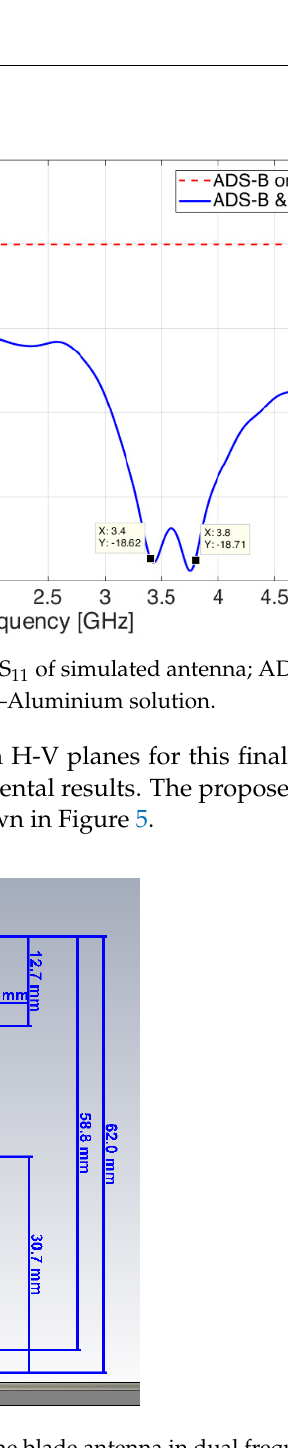
Figure 5. Final dimensions of the blade antenna in dual frequency configuration (XZ side view).